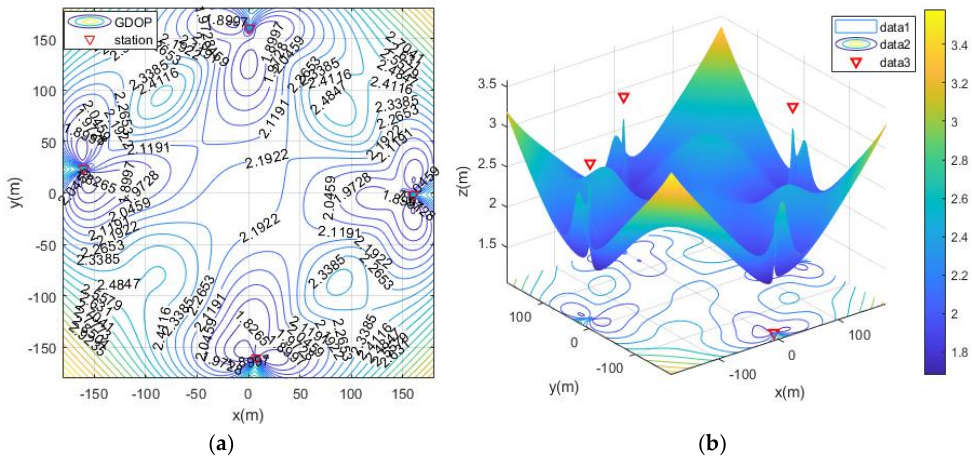
Figure 7. GDOP contour map of optimization results with 4 base stations located surrounding the positioning area . ( a ) 2D contour map of moa01; ( b ) 3D contour map of moa01.